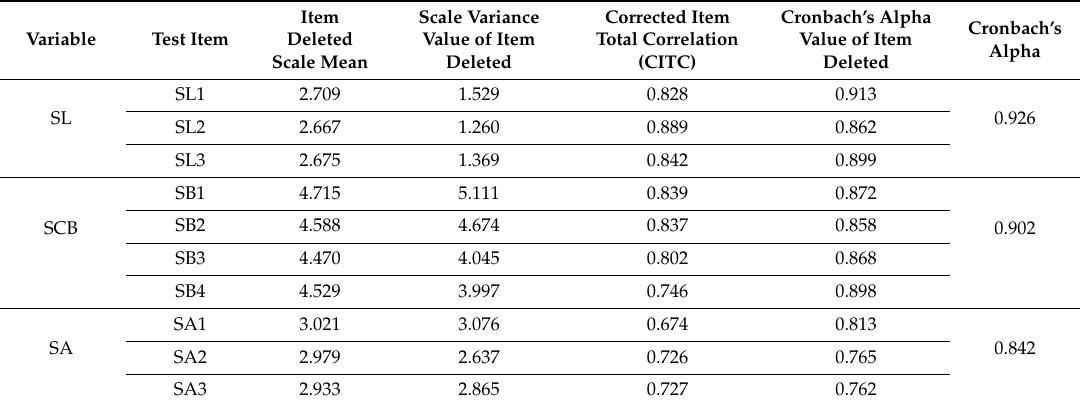
Table 2. Results of reliability analysis of each dimension of the